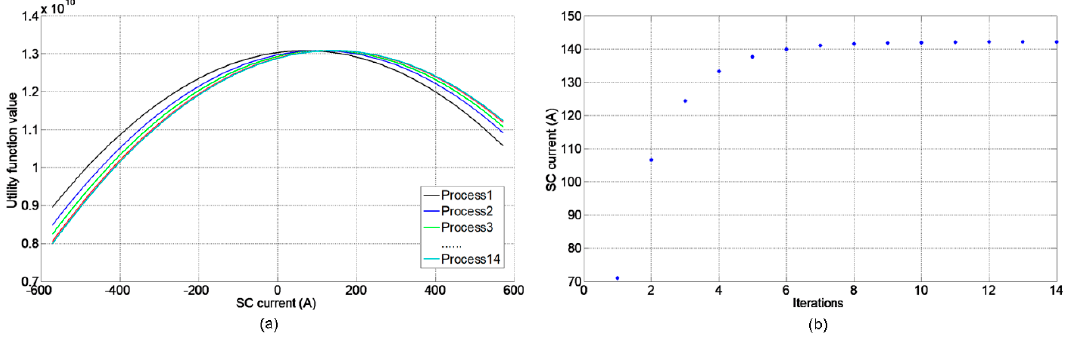
Figure 8. ( a ) The utility function of the SC according to stage of the game; ( b ) the SC strategy according to stage of the game.